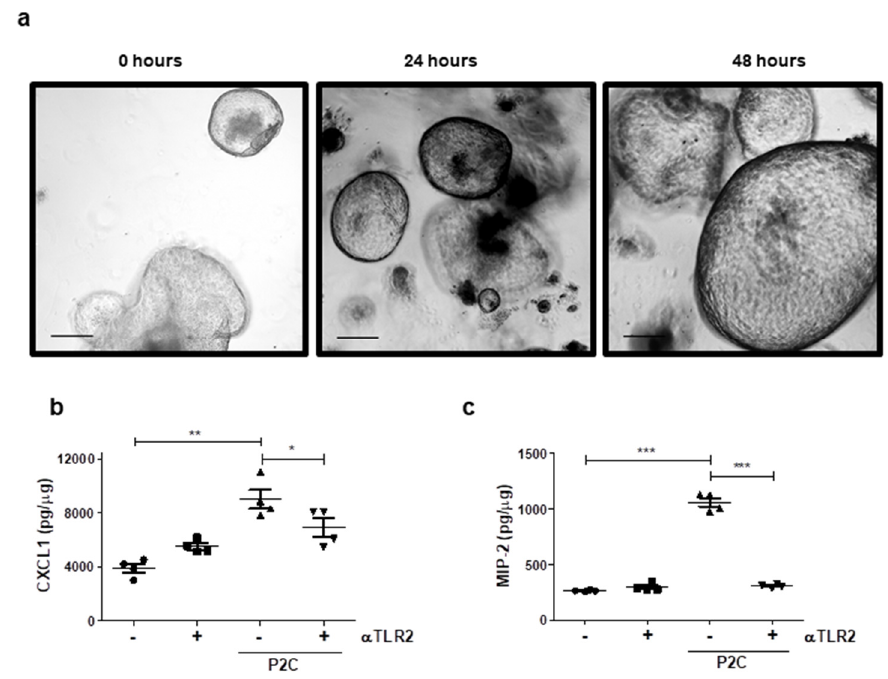
Figure 3. Inhibition of TLR2 in oesophageal organoids from the murine Barrett’s model, pL2-IL-1 β , reduces secretion of the IL-8 orthologs, CXCL-1 and MIP-2. Cells taken from the cardia region at the squamous-columnar junction (SCJ) of 12-month old pL2-IL-1 β mice ( n = 4) were cultured (3 weeks) as 3D organoids. Two days prior to harvesting, organoids were pre-treated (1 h) with α TLR2 Ab (10 µg/mL) before stimulation with P2C (40 ng/mL) for 24 h, the medium was replaced and re-treated ( α TLR2 Ab followed by P2C stimulation) for a further 24 h. ( a ) Representative im- ages of organoid morphology at 0, 24 and 48 h (magnification: 5×, scale bars—200 µm). Organoids were harvested and supernatants were analysed for ( b ) CXCL-1; and ( c ) MIP-2 secretion. Data were normalised to total organoid protein (pg/µg) and are represented as ± SEM. Paired Student’s t -test comparing inhibitor treated to untreated, and unstimulated to stimulated: * p < 0.05, ** p < 0 01, *** p <